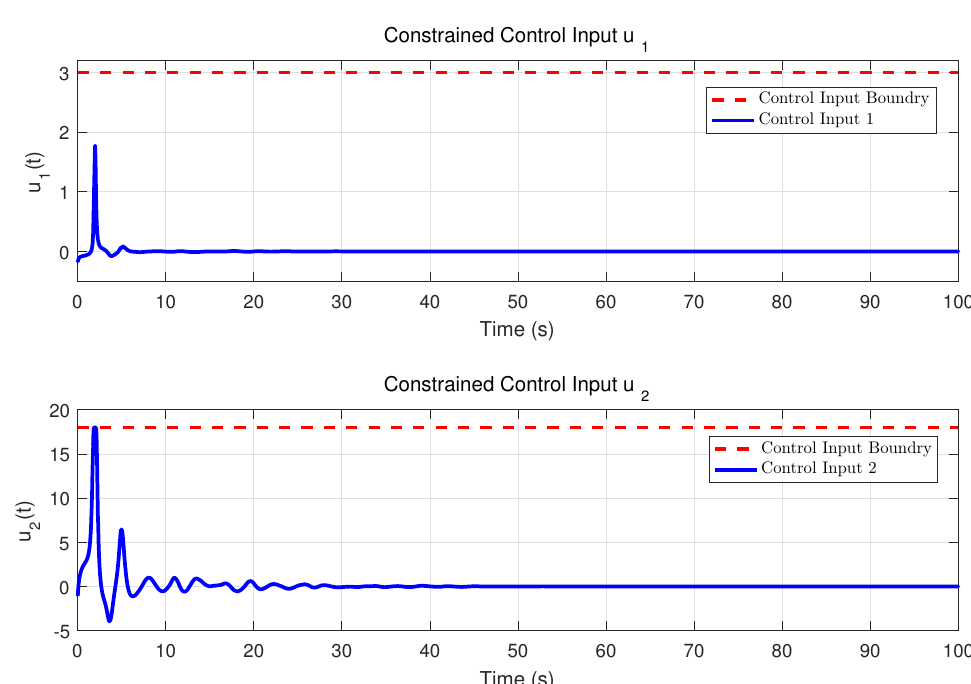
Figure 7. Constrained control inputs of player 1 and player 2.